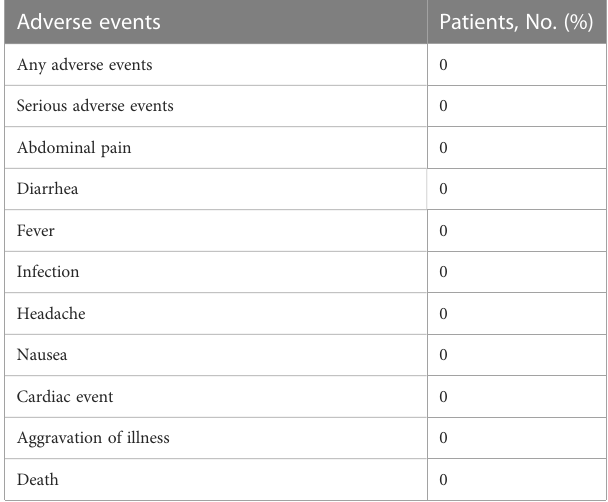
TABLE 3 Adverse events during overall follow-up time. Adverse events Patients, No.